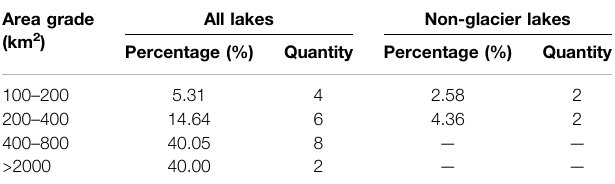
TABLE 2 | Distribution of the areas of studied lakes in